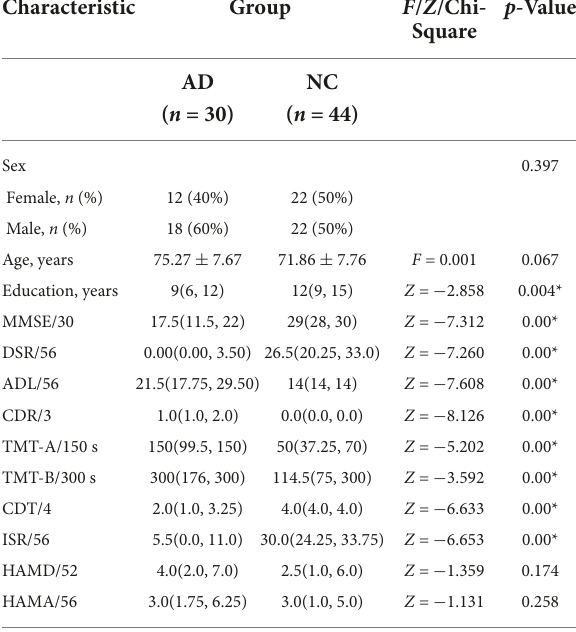
TABLE 1 The characteristics of study